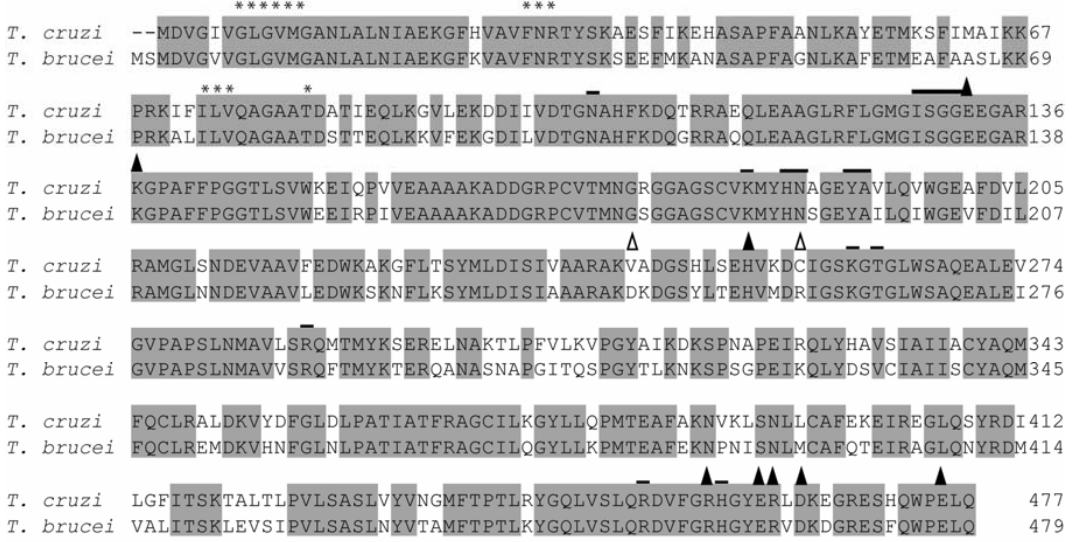
Fig. 4–Alignmentofthededucedaminoacidsequencesofdifferent6-phosphogluconatedehydrogenases. The6-PGDHsfrom T.cruzi (AY300924) and T. brucei (P31072) were aligned using the Clustal program. The asterisks indicate the residues comprising the coenzyme binding site, and those involved in substrate binding are overlined. The triangles indicate the residues involved in the formation of salt bridges in the T. brucei enzyme; empty triangles indicate those absent in the T. cruzi